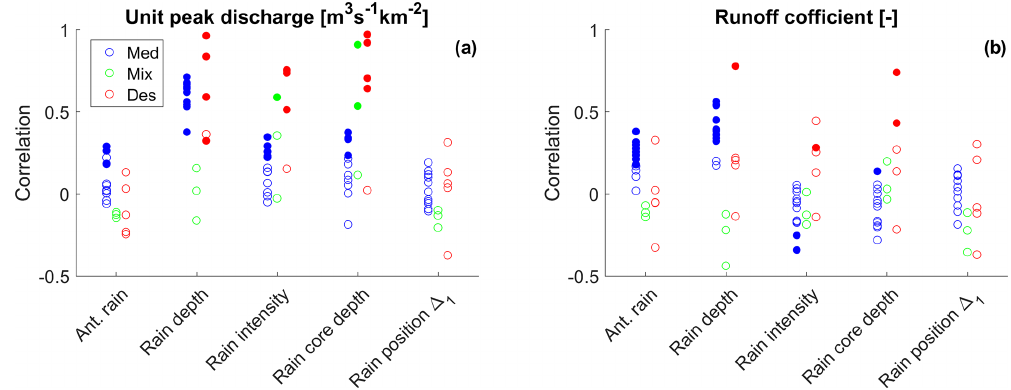
Figure 7. Correlations of the unit peak discharge and runoff coefficient for each basin with more than 15 floods. Each dot represents one basin and filled dots indicate statistically significant correlations (Wilcoxon test, p value < 0 .